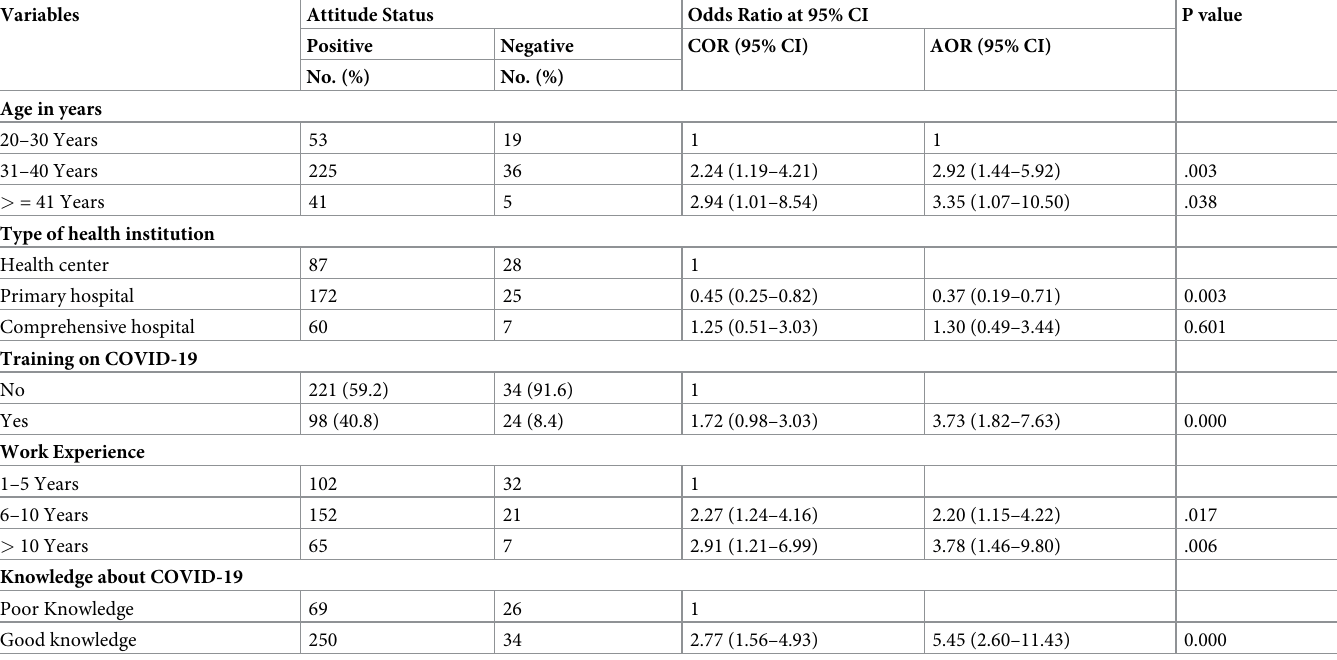
Table 3. Factors associated with attitude of HCWs toward COVID-19 in Silte zone, southern Ethiopia,